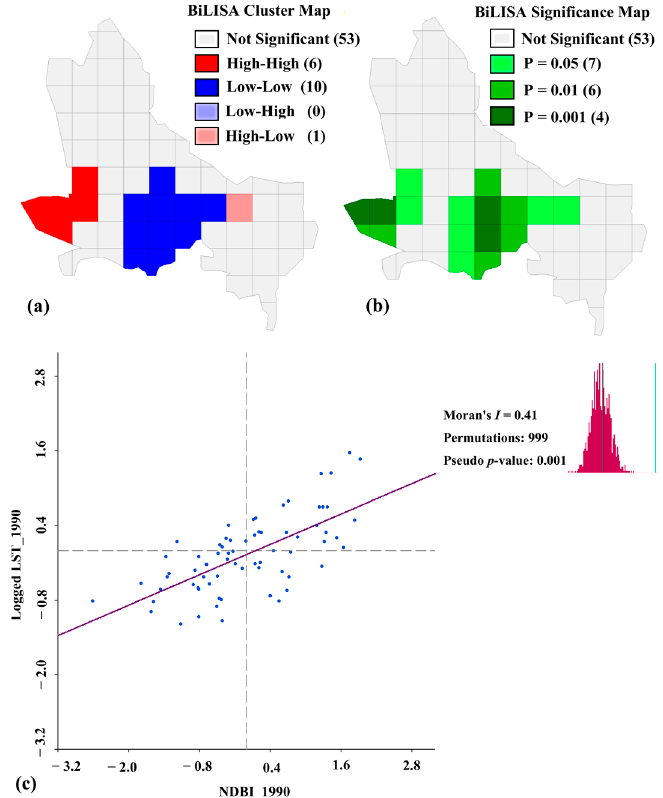
Figure 8. The resultant spatial autocorrelation between LST and NDBI, in which ( a ) represents BiLISA cluster, ( b ) significance maps, and ( c ) Moran’s I , for the year 1990.